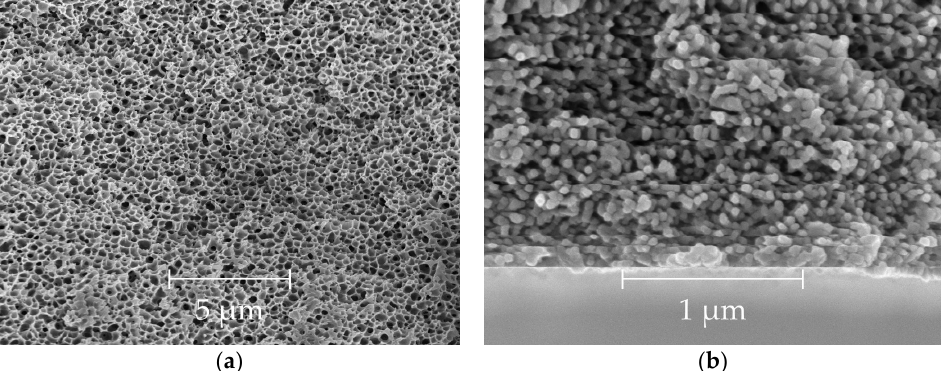
Figure 5. SEM micrographs of hollow fiber cross-section with close-ups of ( a ) the support layer, and ( b ) the inside layer.